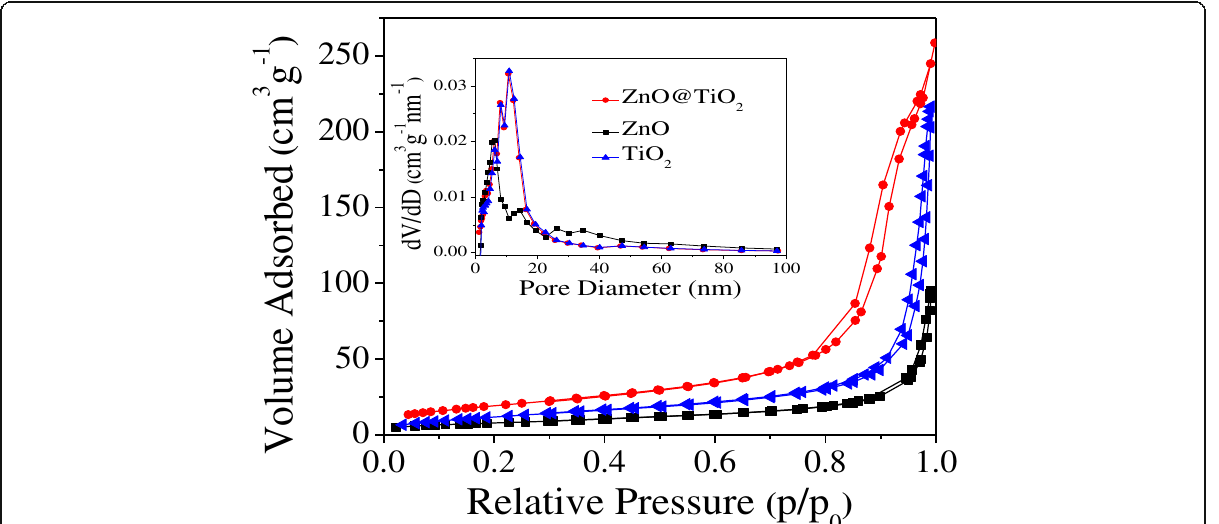
Fig. 4 N 2 adsorption – desorption isotherms and the inset show the corresponding pore size distribution curves